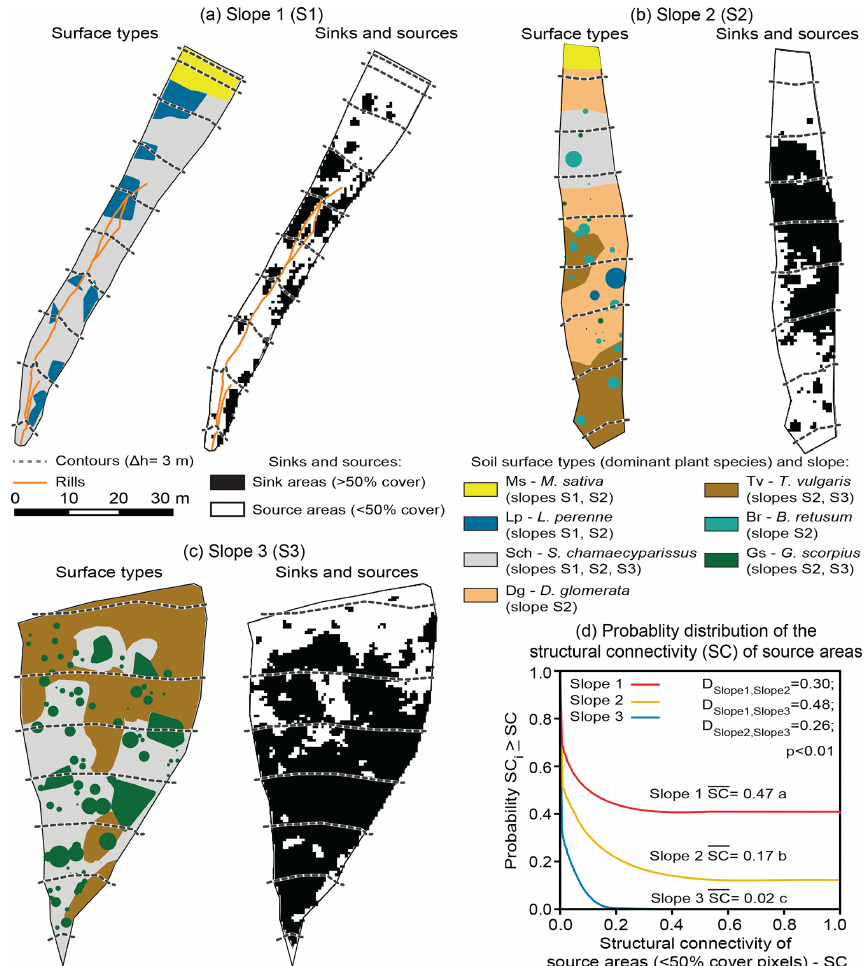
Figure 3. Structural connectivity: (a–c) spatial organization of surface types (vegetation communities) and sink and source areas (i.e. areas above or below 50% vegetation cover) in the experimental slopes; (d) cumulative probability distribution function (CDF) of the structural- connectivity (SC) metric of source areas for the experimental slopes (mean structural-connectivity values, SC, are provided for each slope system). Surface type maps and digital elevation data were derived from a topographical field survey (Merino-Martín et al., 2015). Binary maps (0.5 m pixel resolution) of sinks and sources are derived from a multispectral aerial picture (Spanish National Plan for Aerial Orthopho- tography, PNOA). Different letters in SC values displayed in the graph in panel (d) indicate significant differences at α = 0 . 01. Tested using two-sample Kolmogorov–Smirnov tests ( D statistics and p levels are shown in the